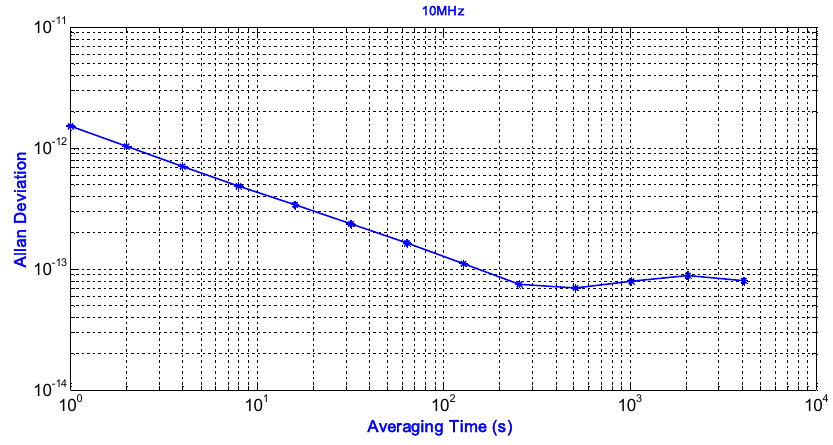
Figure 7. Stability of rubidium atomic clock PRS10.